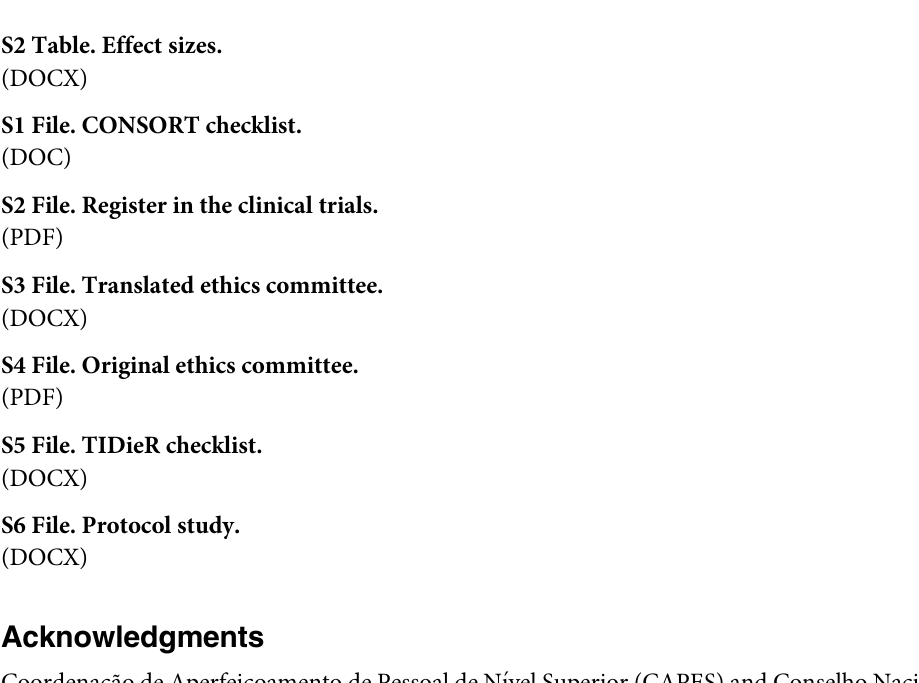
S2 Table. Effect